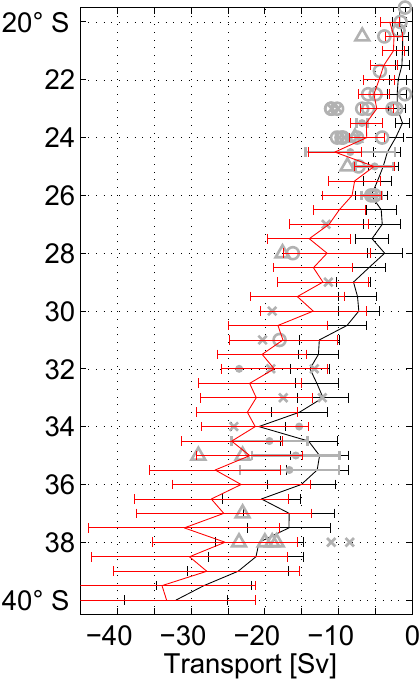
Figure 4. Climatological mean of the meridional transports of the Brazil Current as a function of latitude from observations (black, gray) and HYCOM (red). The black line with error bars shows the mean from Argo&SSH for a layer thickness of 400m north of 27 ◦ S and 800m elsewhere. Gray symbols with or without er- ror bars are from previous studies (see Fig. 1 for references). The symbols indicate if the integration depth is less than 800m (circles), 800m (crosses and dots), or greater than 800m (triangles). Gray er- ror bars are shown if the estimate is from several transects or a time series. Gray dots are based on velocity transects derived by Garzoli et al. (2013) for the purpose of estimating the Meridional Overturn- ing Circulation transports in the South Atlantic. The red line repre- sents the mean with error bars as derived from a combination of the HYCOM reanalysis (1993–2012) and the HYCOM analysis (2013– 2015). All error bars indicate the standard deviation associated with the mean.